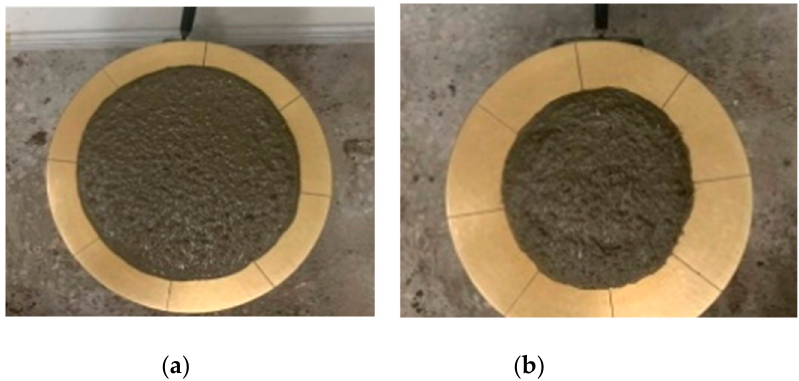
Figure 5. Mortar flow of ( a ) control (0 kg/m 3 AMF) and ( b ) N00F3 (30 kg/m 3 AMF) mixtures.